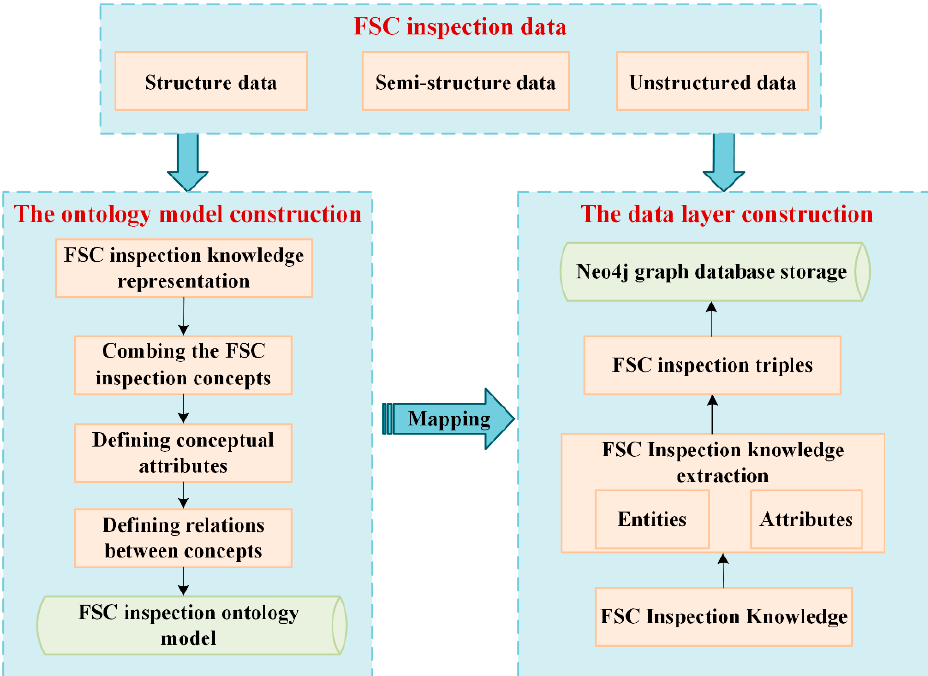
Figure 1. The framework of the FSC inspection construction.